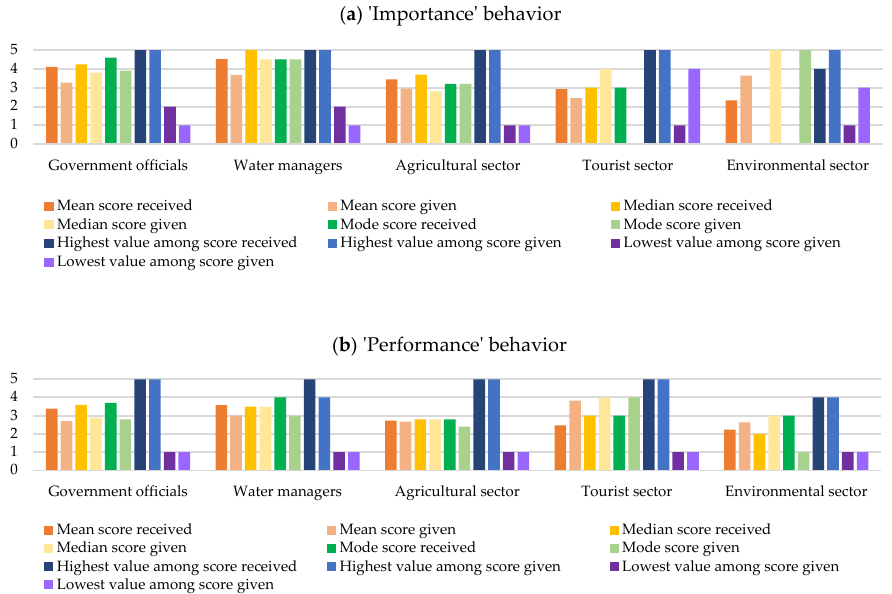
Figure 10. Comparison between Recognition—Importance ( a ) and Assessment – Performance ( b ) behaviors behavior. Legend: 0 (do not know/no answer), 1 (dispensable), 2 (unhelpful), 3 (complementary), 4 (necessary), and 5 (essential).